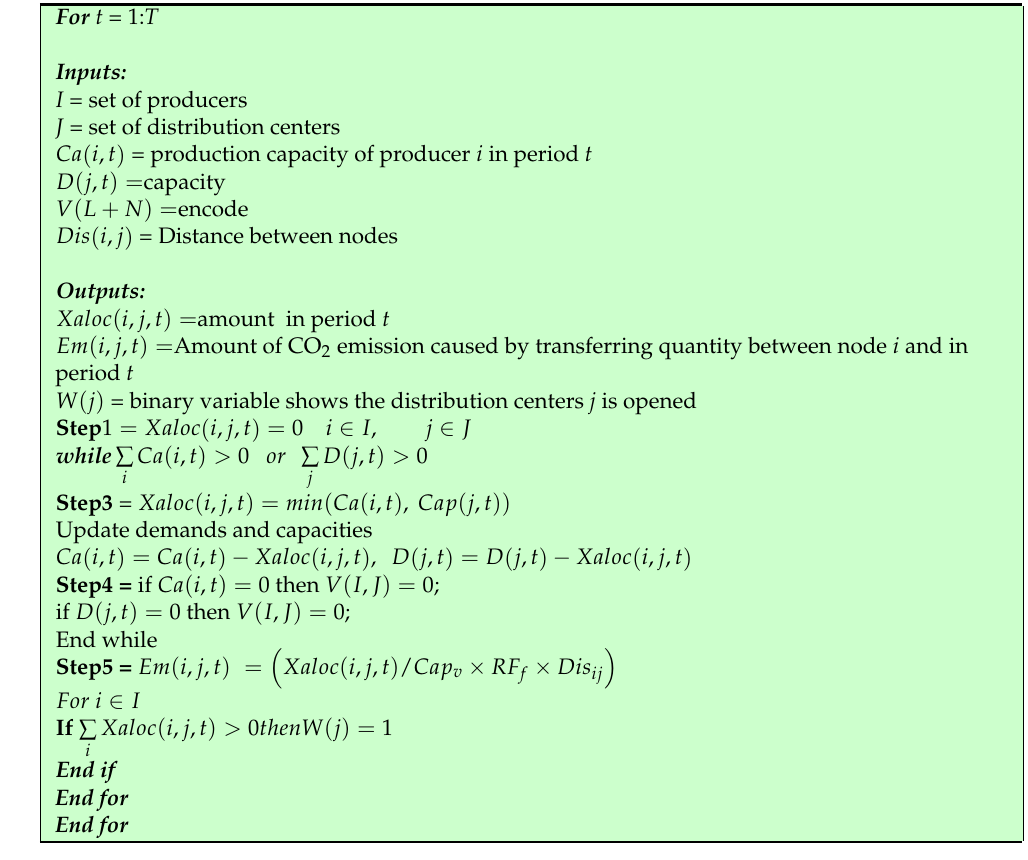
Table 2. Proposed priority-based decoding procedure of segment